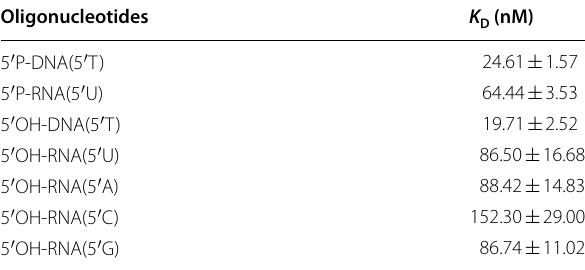
The K D values were measured using a fluorescence polarization assay with various nucleic acids